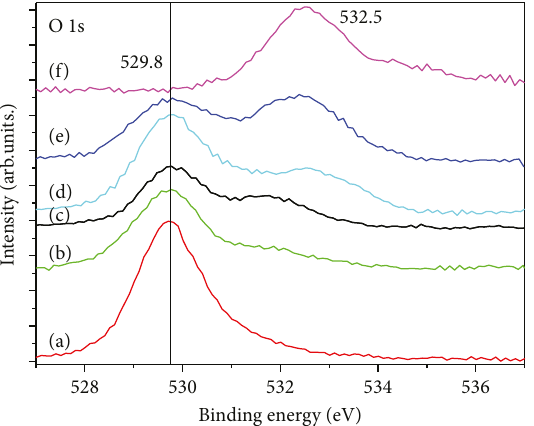
Figure 8: XPS spectra evolution of O 1s region as a function of bismuth content, (a) 0, (b) 0.5, (c) 4.9, (d) 10.4, (e) 21.5, and (f) 25.4at. %.